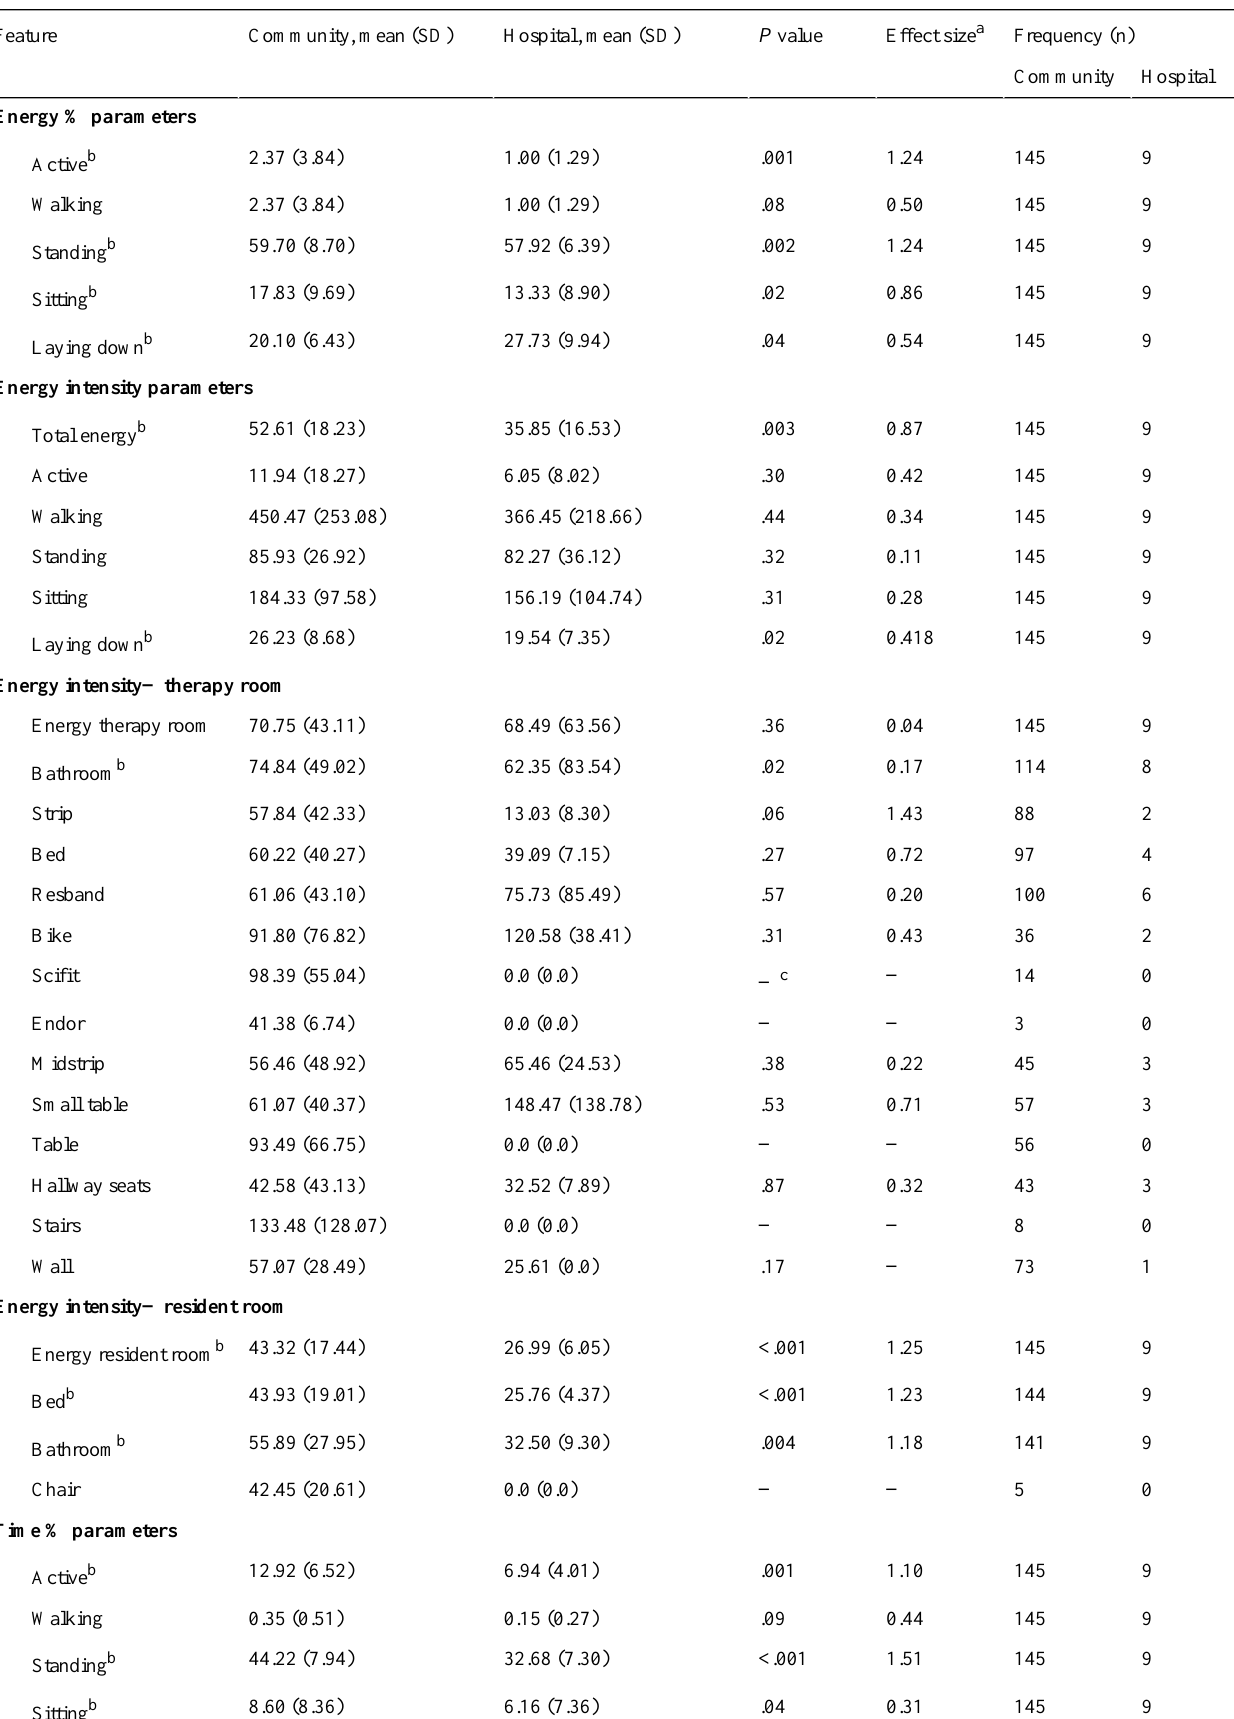
Table 5. Sensor-based (activity and indoor localization) features: assessment according to